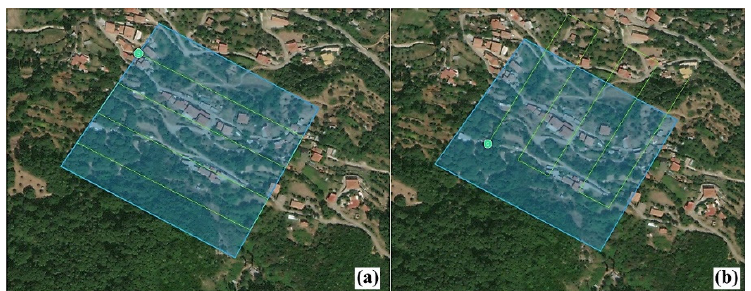
Figure 5. UAV acquisitions over the landslide of Messarista. ( a ) Nadir-viewing acquisition trajec- tory; ( b ) Oblique-viewing acquisition trajectory. ( b ) Oblique-viewing acquisition